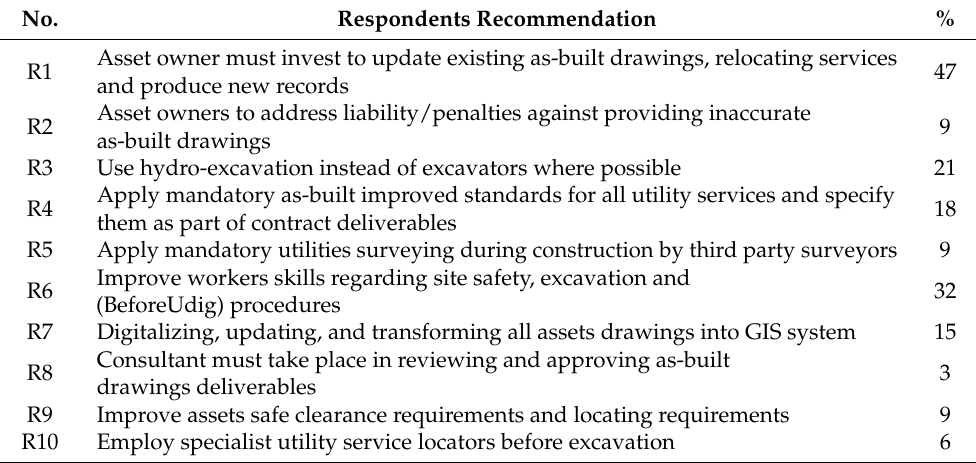
Table 4. Recommendation for improving as-built